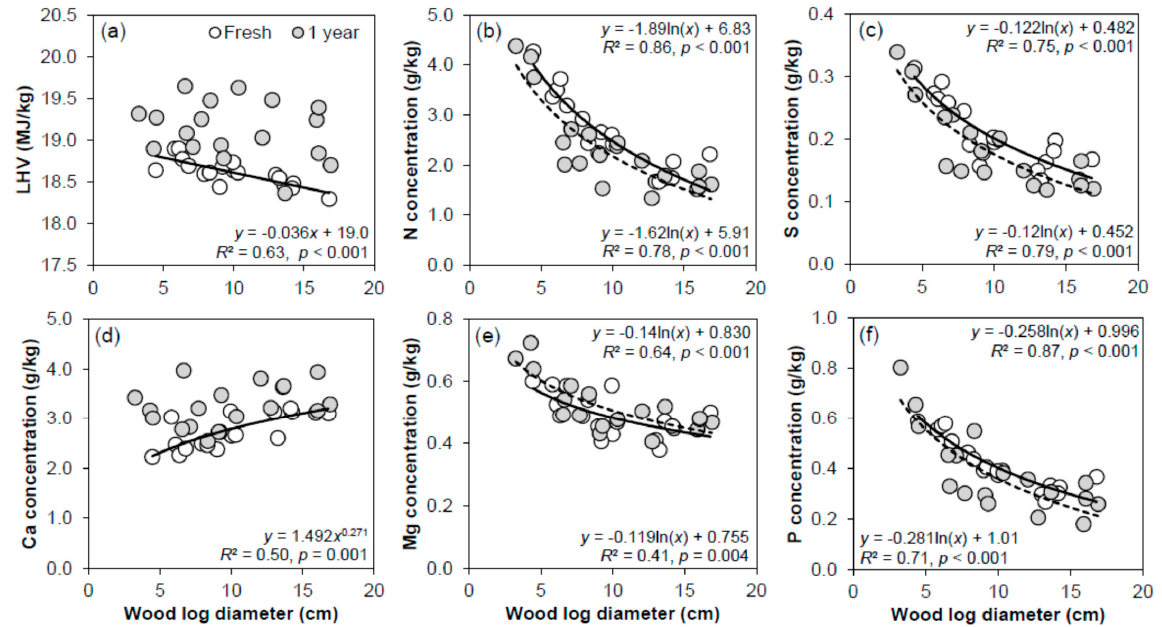
Figure 5. Relationships between hybrid poplar firewood log diameter (110 cm in length) and their ( a ) lower heating value (LHV dry ) or ( b – f ) elemental concentration at harvest (Fresh, solid line) and after one year of drying outdoors (1 year, dashed line). n = 18 for each relationship. Table 2. Diameter class and drying treatment effects on chemical properties of unsplit hybrid poplar firewood logs (110 337 cm in length). S.E. = standard error of the mean. p -values in bold denote a significant effect.